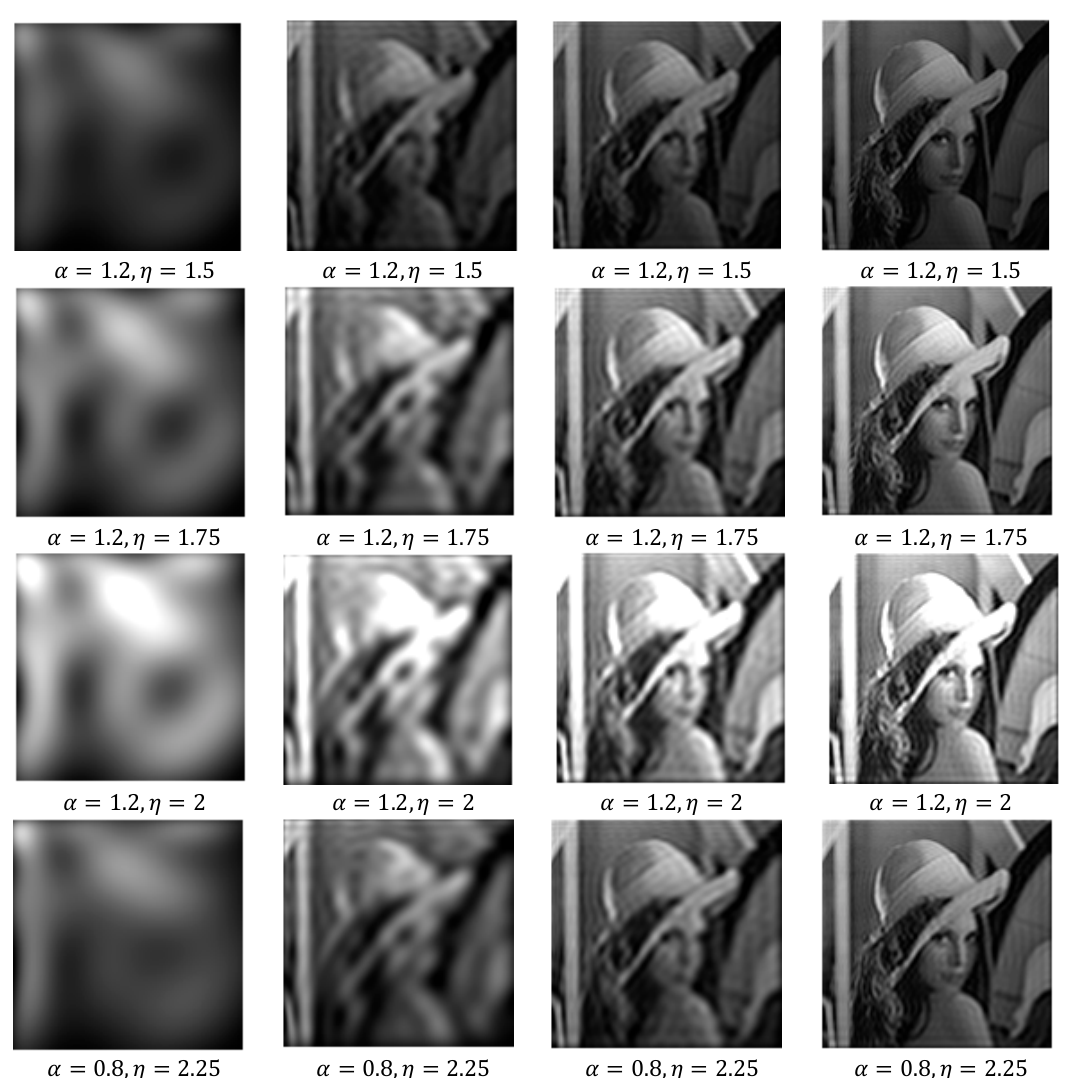
Figure 6. Columns 1 to 4 shows the reconstructed gray-level images with order 16, 50, 100, and 150, respectively, from GFCMs.